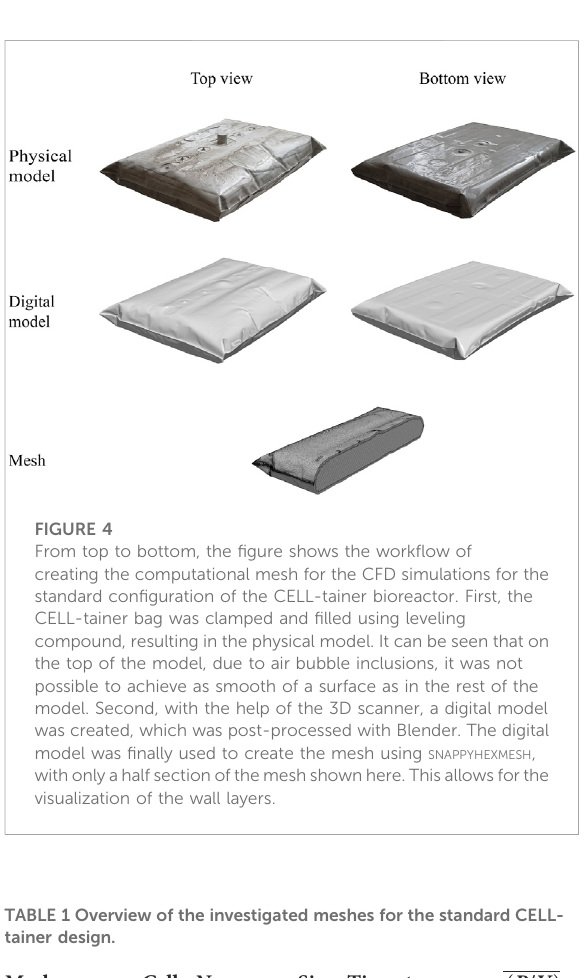
TABLE 1 Overview of the investigated meshes for the standard CELL- tainer design. Mesh Cells N [-] speci fi c oxygen surface area a , and thus the k L a value. Figure 6B shows the velocity magnitude over the line marked in red in Figure 6A. There is a deviation, especially for the fi rst mesh. Table 2 was performed. The speci fi c power input averaged over a period of motion was used as a criterion for the GCI, which was calculated via the turbulent and viscous energy dissipation (Section 3.3.2). It is known that for unstructured meshes like the ones created with SNAPPYHEXMESH , there are higher GCI results, compared to structured meshes (Liu et al.,